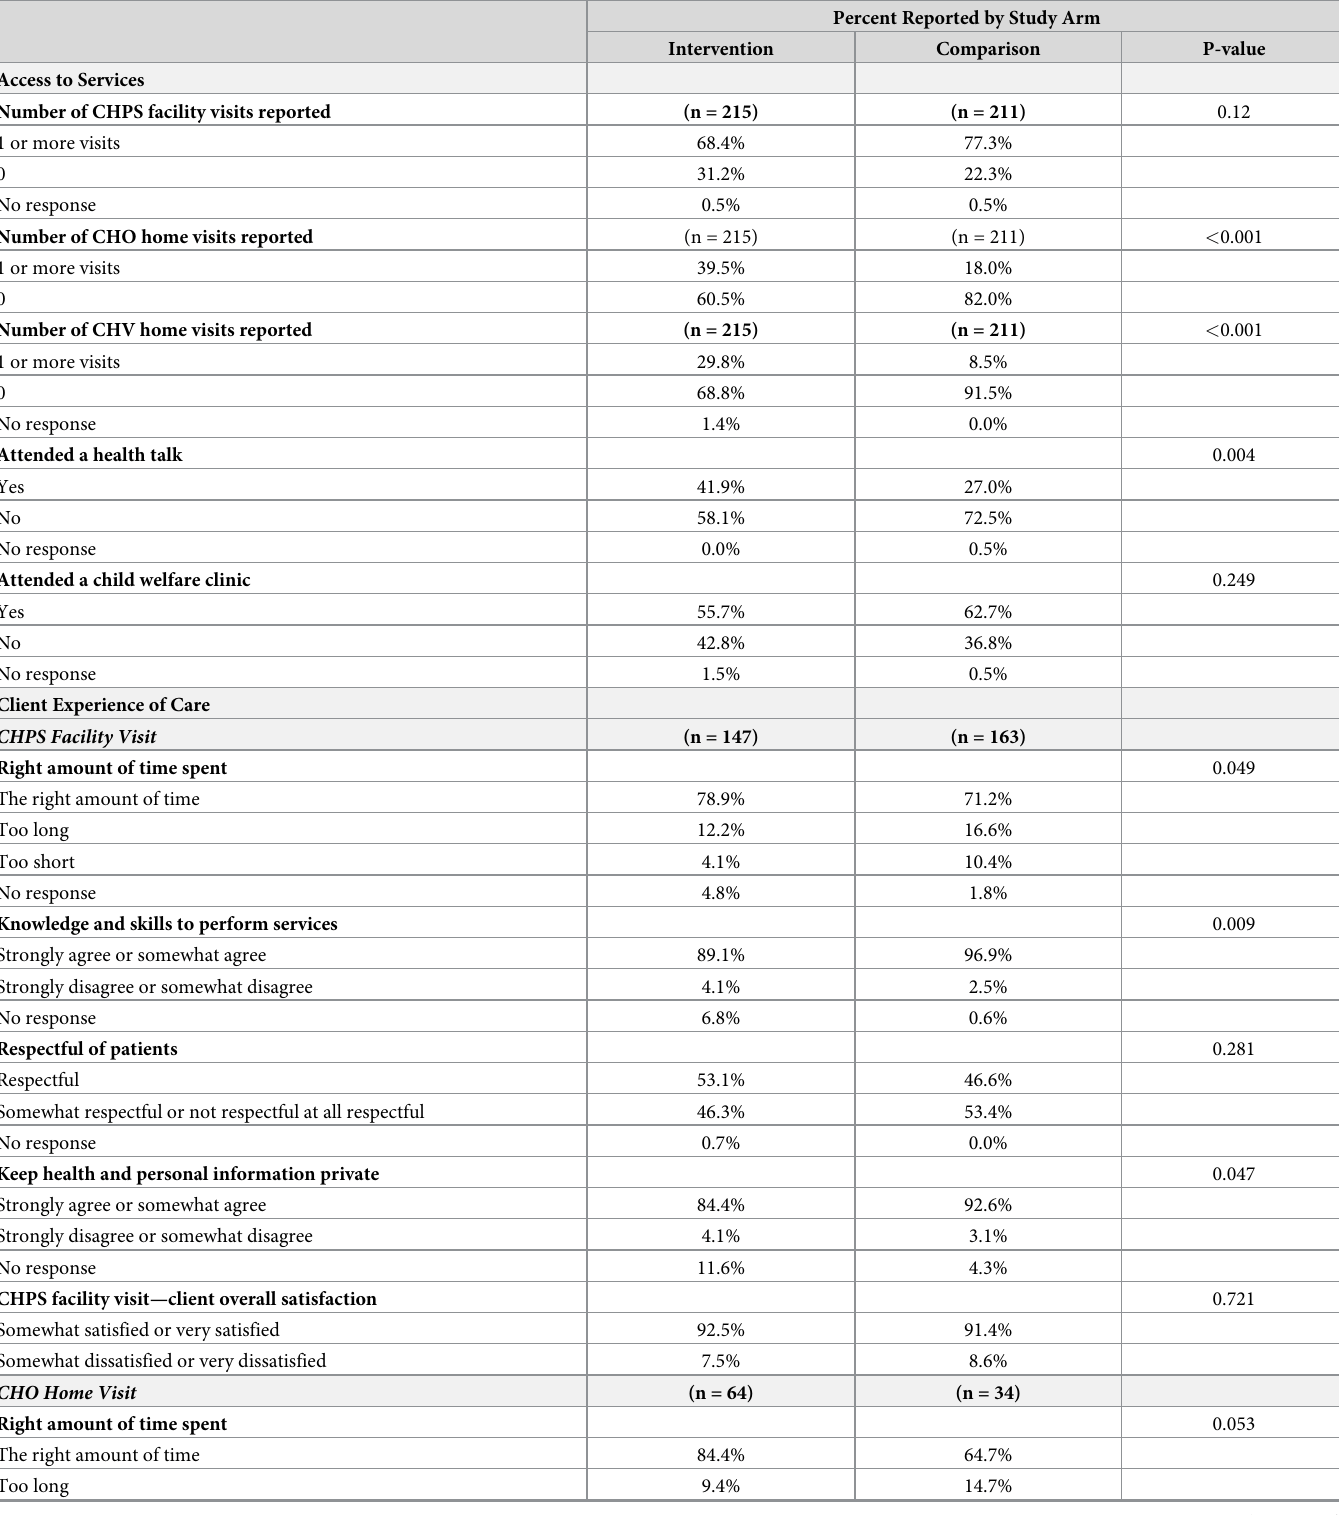
Table 5. Bivariate analyses of household questionnaire by study arm.